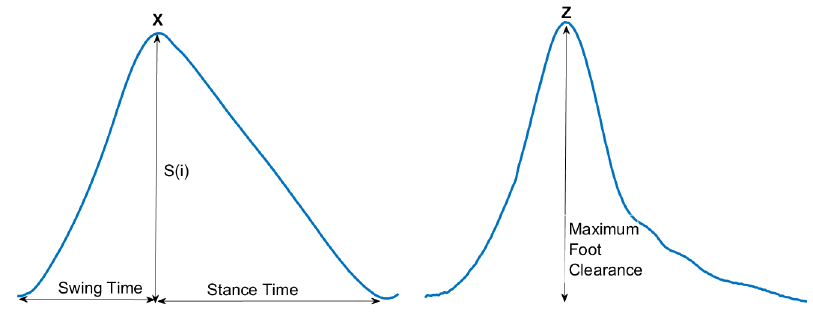
Figure 7. Estimation of gait parameters from a single gait